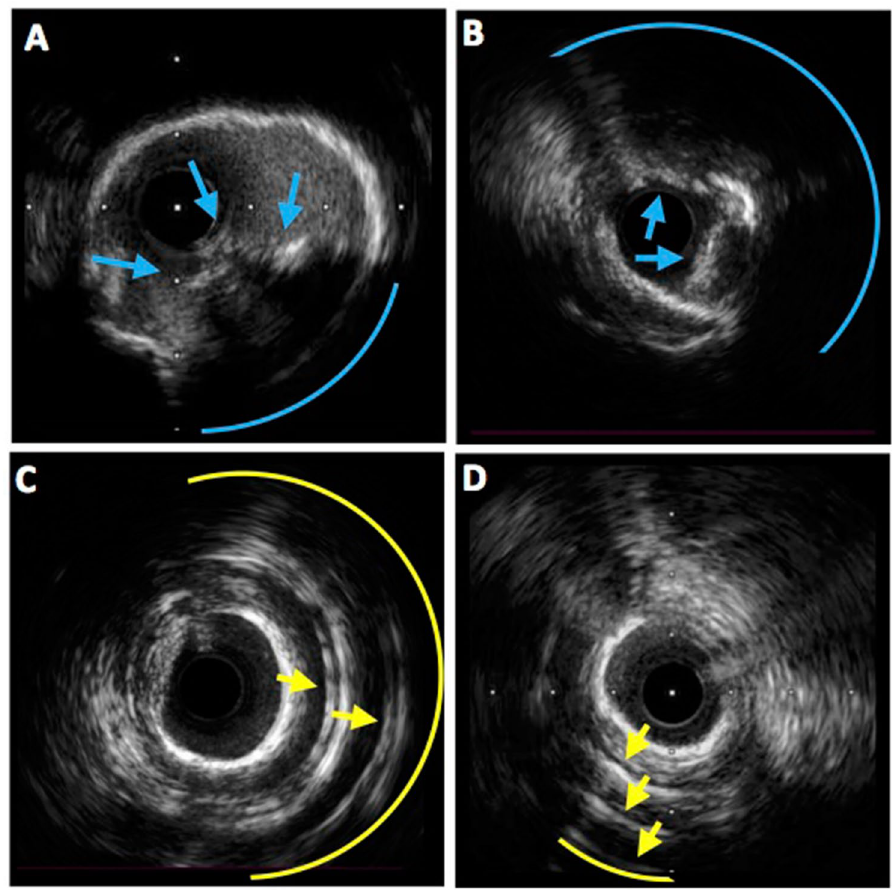
Figure 1. Evaluation of reverberation and calcified nodule. ( A ) Calcified nodule (blue arrows) showing irregular surface and convex shape with the distribution of one quadrant (blue arc). ( B ) A cross-sectional IVUS image showed calcified nodule (blue arrows) extending to two quadrants (blue arc). ( C ) A cross-sectional IVUS image showed two lines of reverberations (yellow arrows) with the distribution of nearly two quadrants (yellow arc). ( D ) There were three arctic lines of reverberations (yellow arrows) with the distribution of less than one quadrant (yellow arc). IVUS intravascular